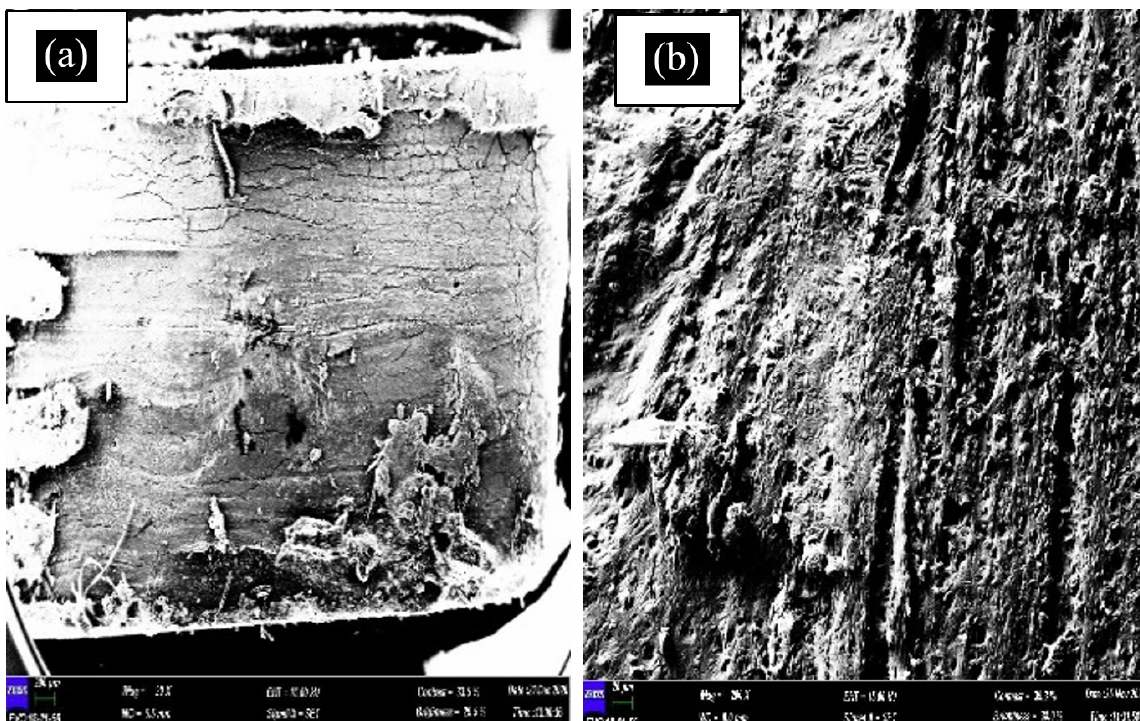
Figure 9. SEM micrograph of pure TPCS ( a , b ).